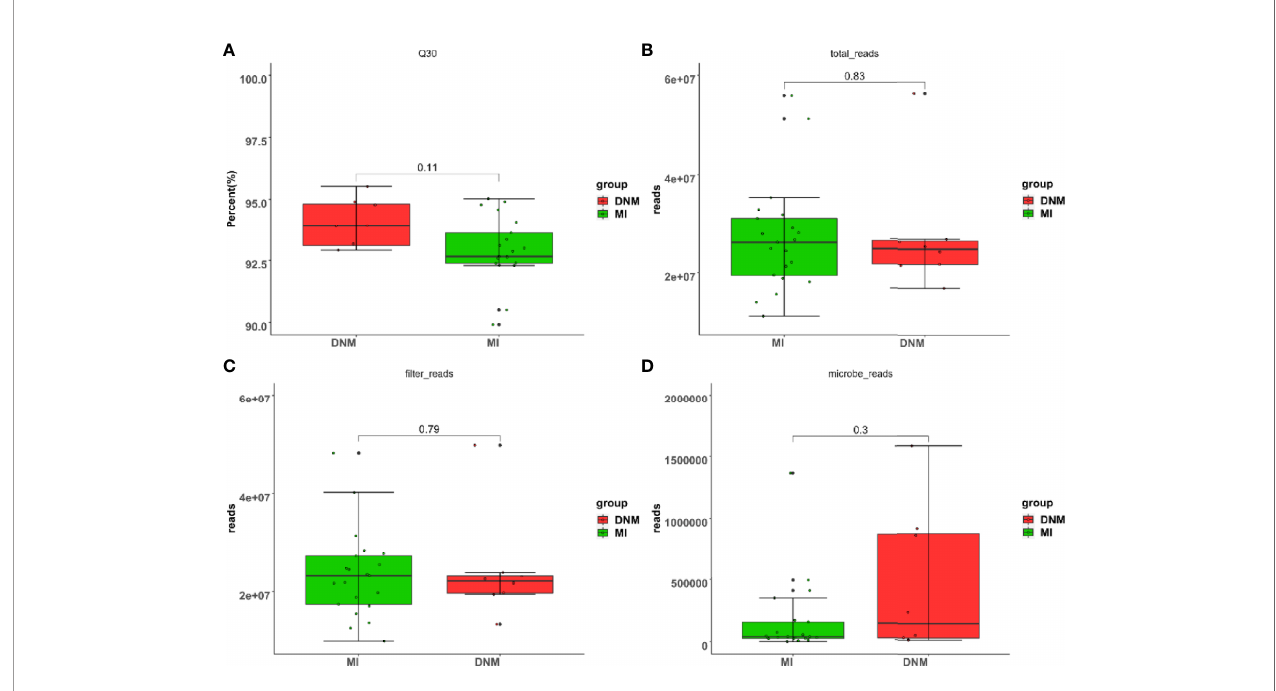
FIGURE 1 | Data quality control sketch. (A) raw data Q30 scale statistics, (B) total reads, (C) fi lter reads, (D) microbe